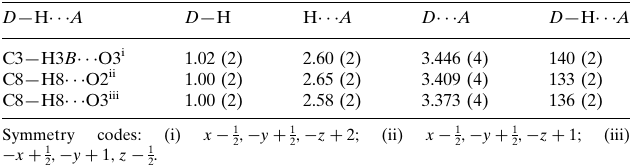
Hydrogen-bond geometry (A˚ , (cid:1)